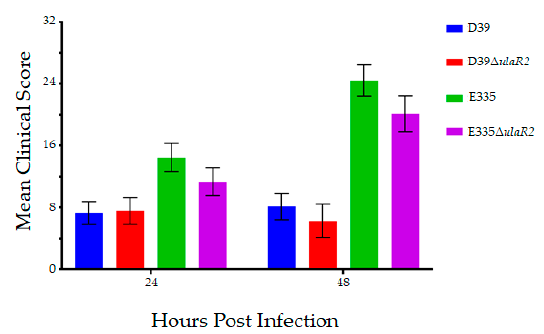
Figure 2. Mean clinical scores of eyes 24 and 48 h after infection. Eyes infected with each parent strain and its corresponding isogenic ulaR2 mutant strain produced clinical scores that were not significantly different from each other. Error bars represent standard errors of the means.